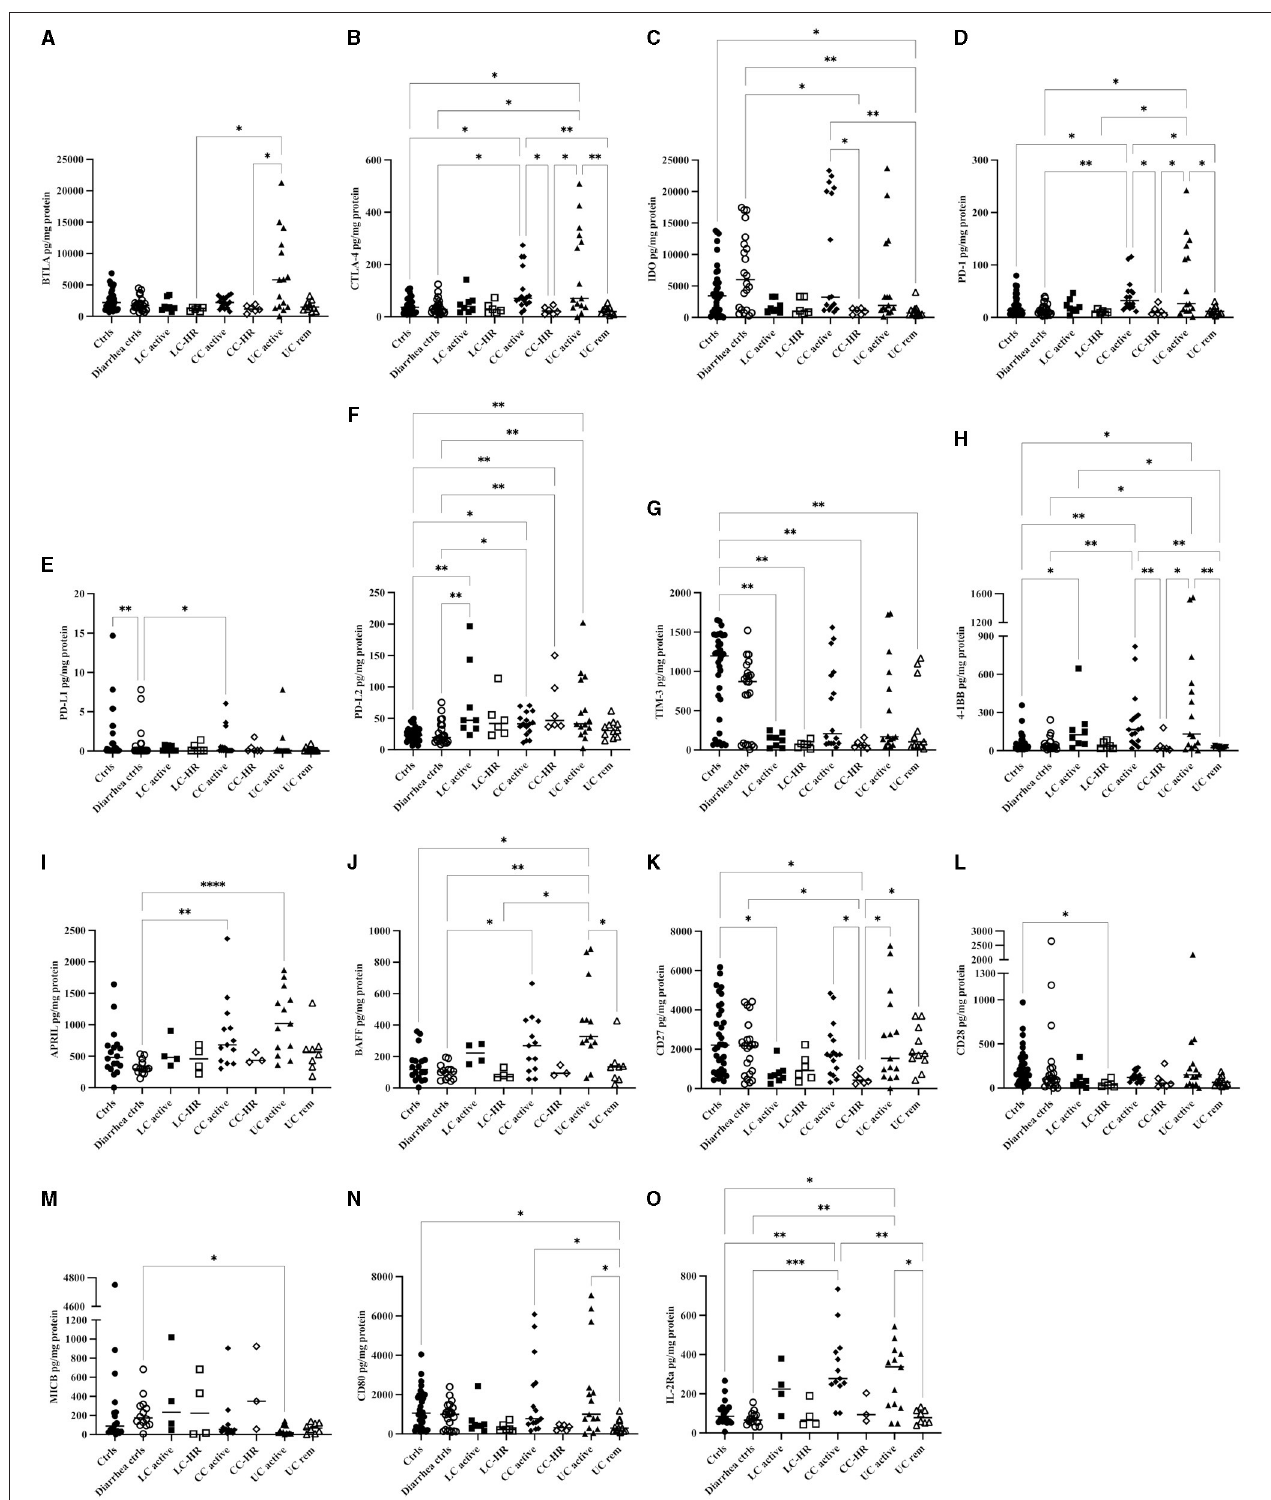
FIGURE 4 | Concentrations in pg/mg protein of all 15 analytes that were significantly altered in protein lysates from colonic biopsies from patients with active lymphocytic colitis (LC) and LC in histological remission (HR), active collagenous colitis (CC) and CC in HR, as well as active ulcerative colitis (UC) and UC in remission compared to controls. (A) BTLA, (B) CTLA-4, (C) IDO, (D) PD-1, (E) PD-L1, (F) PD-L2, (G) TIM-3, (H) 4-1BB, (I) APRIL, (J) BAFF, (K) CD27, (L) CD28, (M) MICB, (N) CD80, (O) IL-2R α . Each point represents one patient, and the median is shown as a horizontal line. Q -values obtained from performing the original false-discovery rate method of Benjamini–Hochberg are shown as * q < 0.05, ** q < 0.01, *** q < 0.001, **** q < 0.0001.